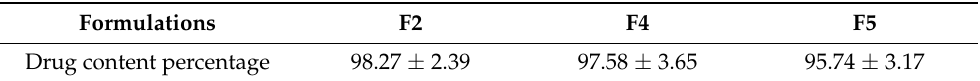
Table 4. Drug content uniformity.